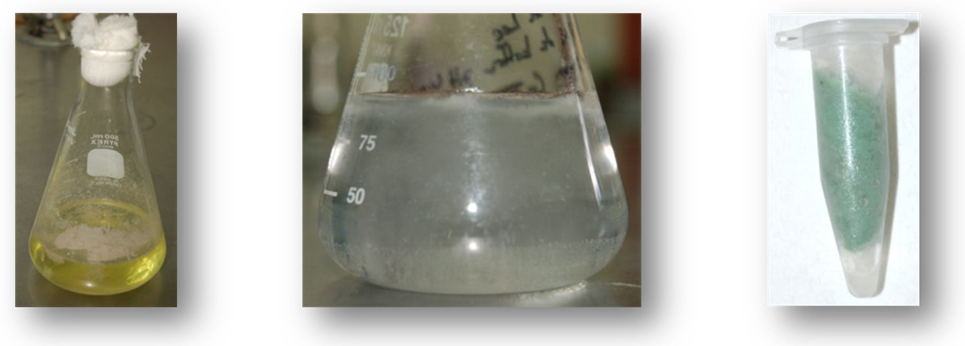
Figure 9. Gradual conversion from Cr (VI) to Cr (III) with green precipitate observed in the mixed membrane fraction of Purpureocillium lilacinum after 15 days at 37 ◦ C with 20 mg/L Cr membrane fraction of Purpureocillium lilacinum after 15 days at 37 °C with 20 mg/L Cr (VI).